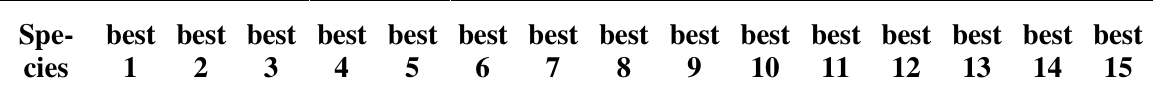
Table A2.1: Single species and mean bird indicators for the 15 best solutions (best 1 – best 15). Species abbreviations stand for: Sr - Saxicola rubetra (Whinchat), Cm - Coloeus monedula (Western Jackdaw), Aa - Alcedo atthis (Common Kingfisher), Pp - Phoenicurus phoenicurus (Common Redstart), Gc - Galerida cristata (Crested Lark), La - Lullula arborea (Wood Lark), Vv - Vanellus vanellus (Northern Lapwing), Ta - Tyto alba (Barn Owl), Oo - Oenanthe oenanthe (Northern